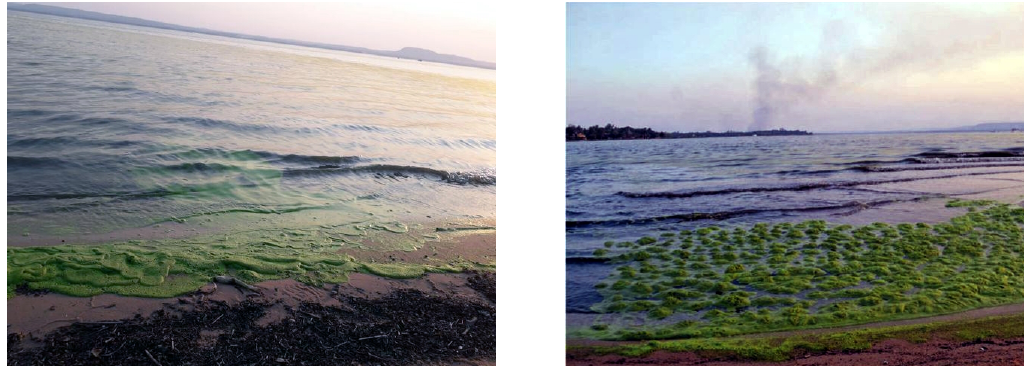
Figure 2. Last appearance of algal bloom at the shore of Ypacarai Lake (February 2019)